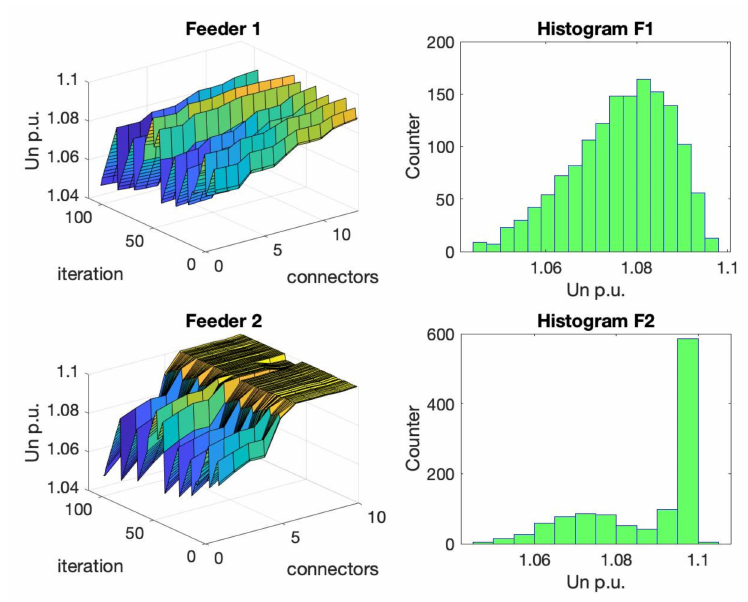
Figure 29. Power flow data distribution—optimal operation of connection points.